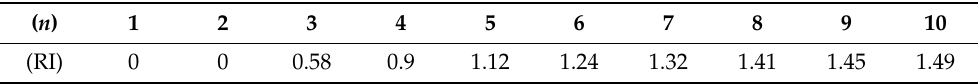
Table 2. Average RI for corresponding matrix size.